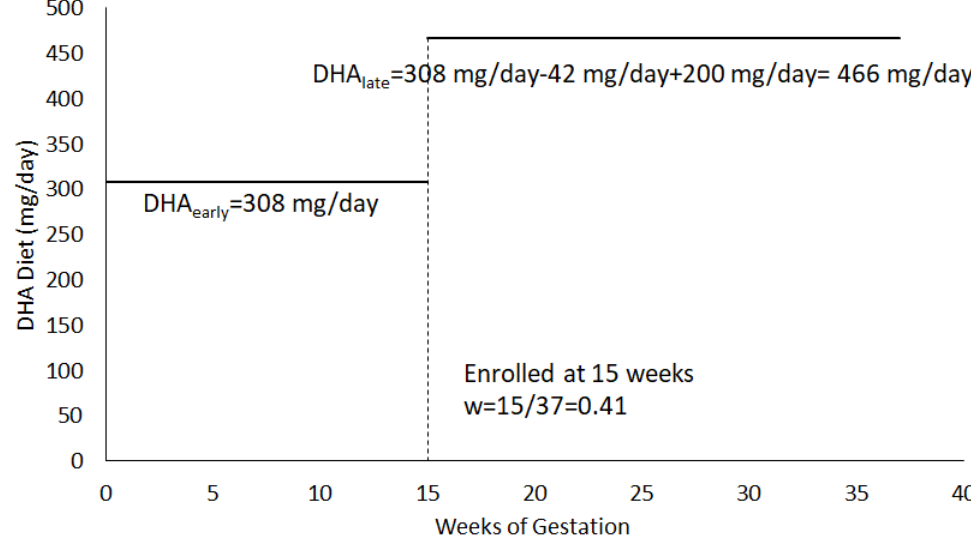
Figure 1. Example DHA Exposure Calculation for a participant randomized to 200 mg/day. For this example, DHA intake = 0.41 ∗ 308 + ( 1 − 0.41 ) ∗ 466 = 401.22 mg/day .